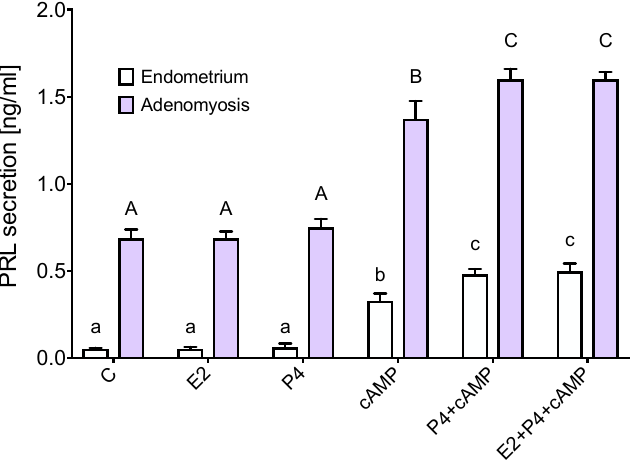
Figure 6. Prolactin secretion in endometrial and adenomyotic explants. Secretion of prolactin in endometrial and adenomyotic explants after 72 h stimulations. Significant differences ( p < 0.05) are indicated by different letters above the bars (lower- and upper case letters for endometrium and adenomyosis, respectively). C, control; cAMP, 8-bromo-cAMP; E2, estradiol; M, myometrium; P4, progesterone.